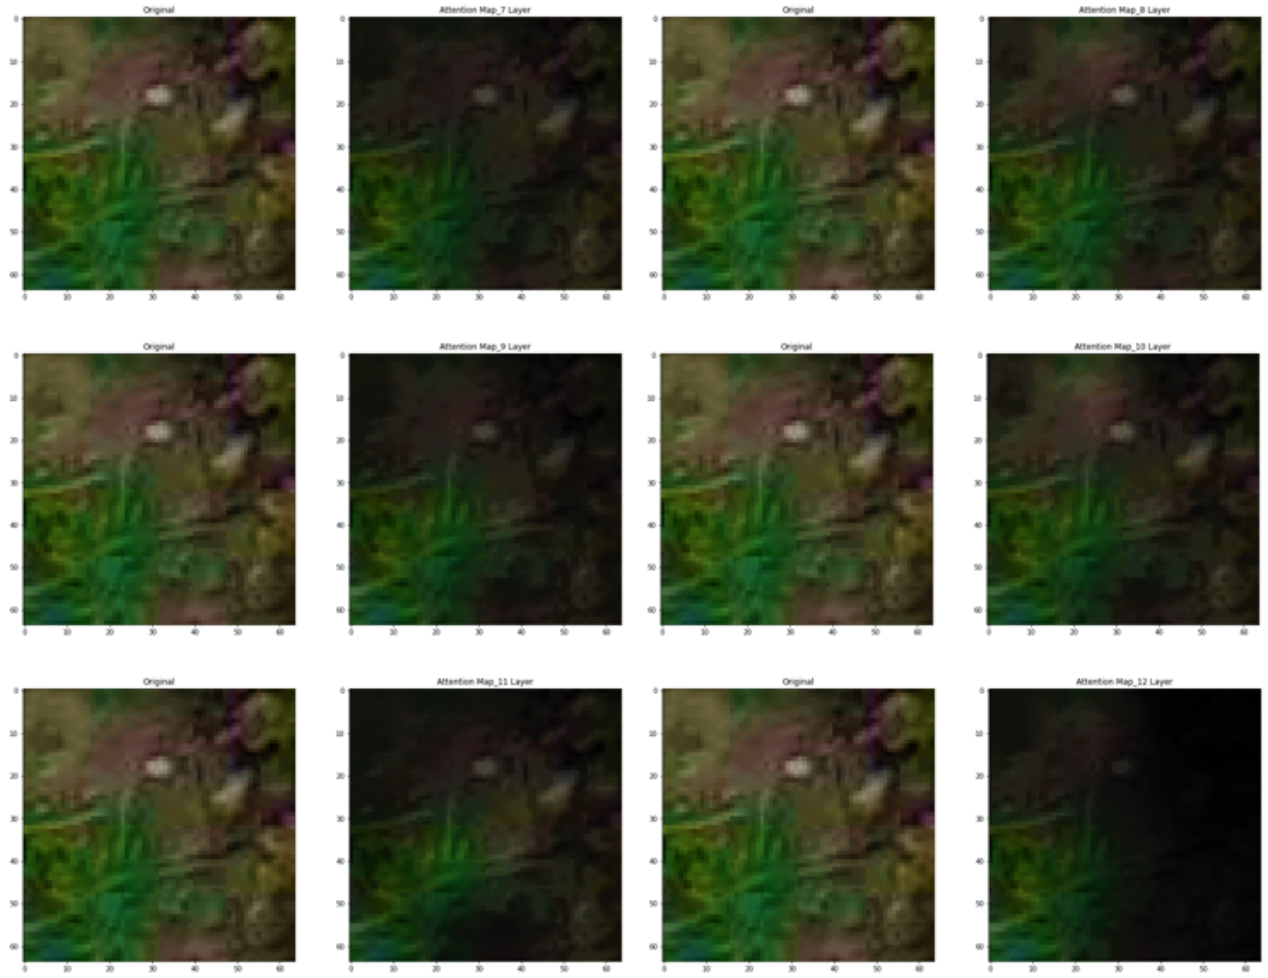
Figure 6. Attention map generated from layers 7 to 12 of the ViT-B16 model on an image of a